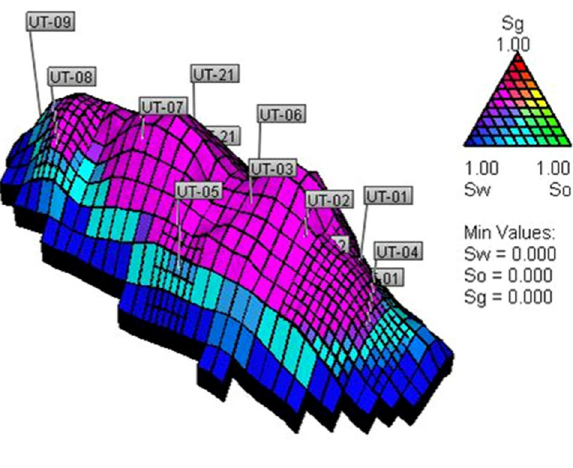
Fig. 11 A 3D view of the history-matched E1 model. The production wells are labelled, while the ternary diagram on the top right corner depicts the gas ( S g ), oil ( S o ) and water ( S w ) saturations at any instant. Areas of intermediate saturations, which suggest reservoir sweep, are evident in various colour shades between the saturation bounds 0.0 and 1.0 as applicable